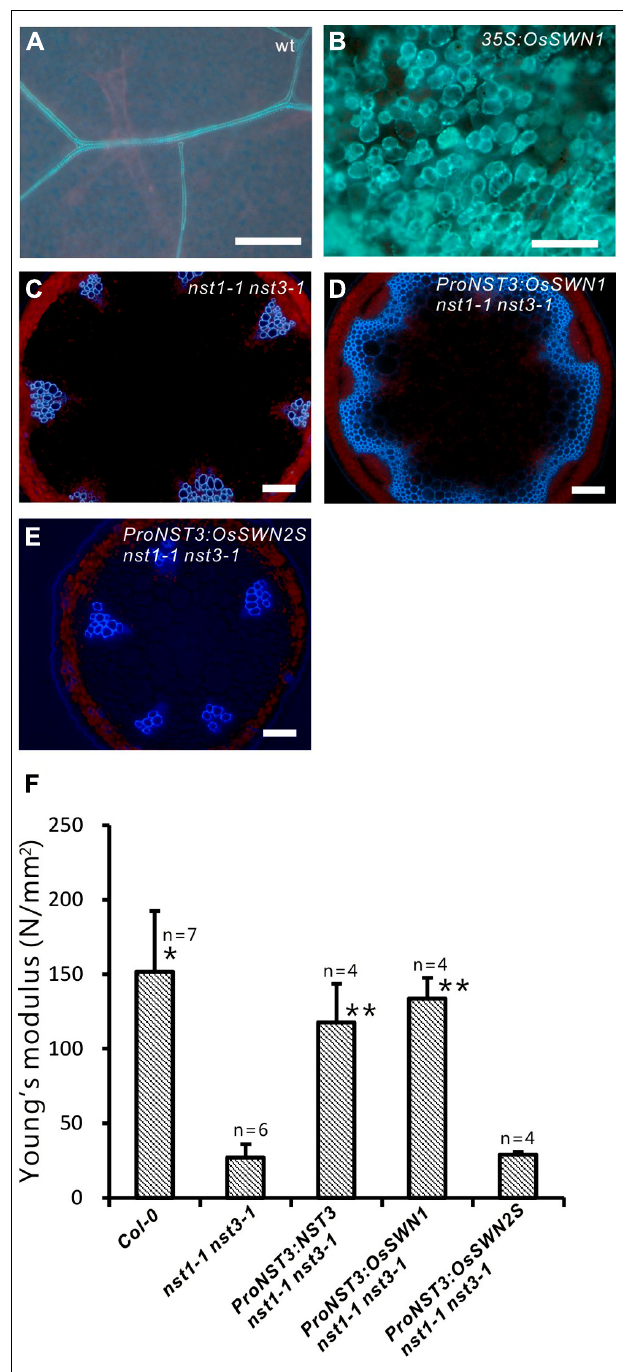
FIGURE 2 | OsSWN1 but not OsSWN2S restored the phenotype of nst1-1 nst3-1 . (A–E) Fluorescence images under UV illumination. Blue auto-fluorescence represents lignin.Wild-type leaf (A) , leaf of 35S: OsSWN1 Arabidopsis (B) , cross section of stem of nst1-1 nst3-1 double mutant (C) , nst1-1 nst3-1 ProNST3:OsSWN1 (D) and nst1-1 nst3-1 Pro NST3:OsSWN2S Arabidopsis (E) . Bars represent 100 μ m. (F) Comparison of physical strength (Young’s modulus) of inflorescence stem. “*” and “**” indicate values significantly different from the nst1-1 nst3-1 mutant byWelch’s t -test with P < 0.05 and 0.01,